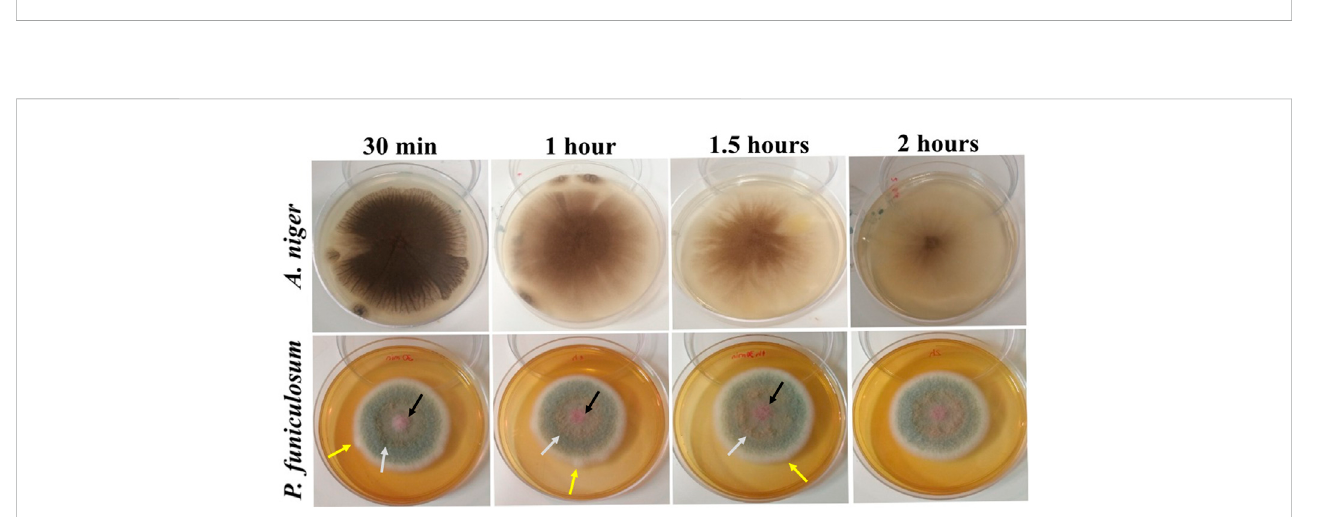
FIGURE 5 Fungal growth after treatment with Ag@ACF fi ltration from 30 min to 2 h. Ag@ACF fi ltration showed a strong antifungal effect for A. niger , with effective growth reduction over time. P. funiculosum had a slight reduction effect with a pink central area and diffuse high to fl at growth (black and gray arrows) over treatment time and a slight growth reduction of the outer margin (yellow